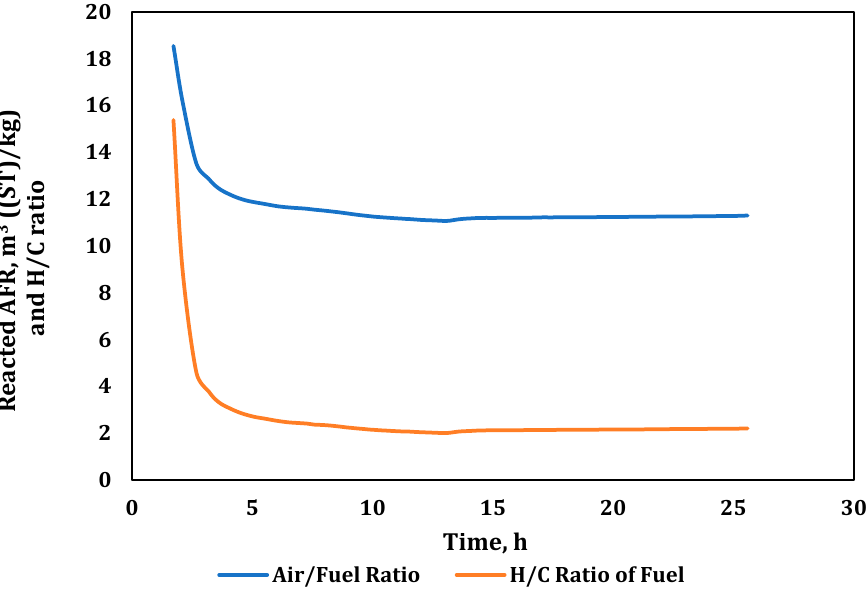
Figure 14. Reacted AFR and apparent H/C ratio.